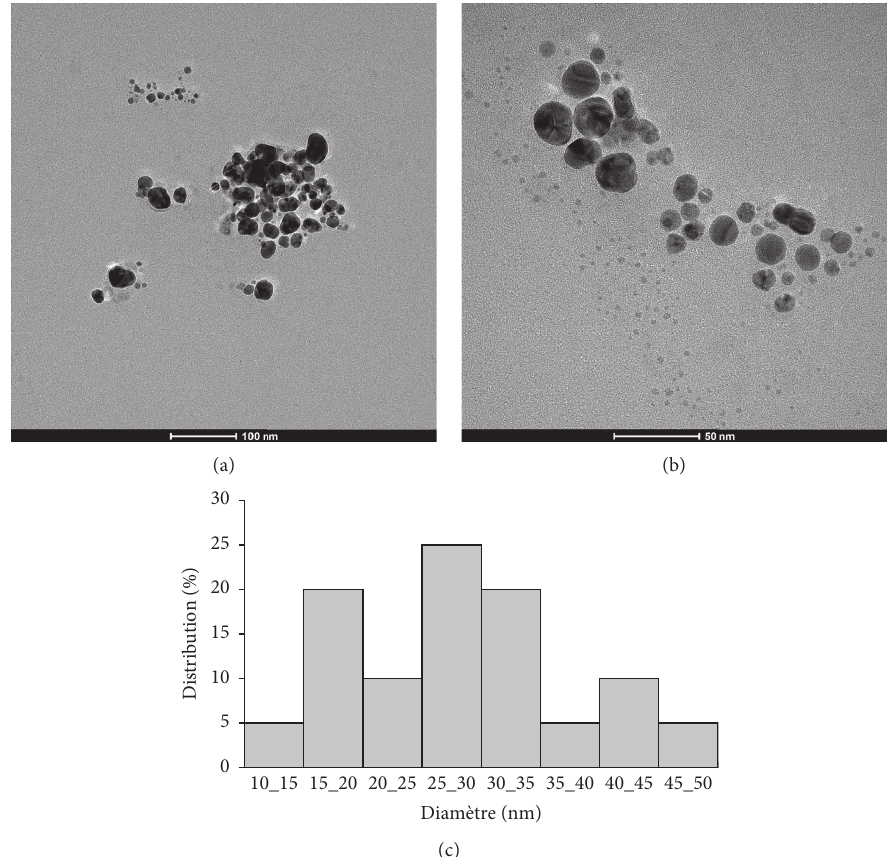
Figure 2: TEM analyses of biosynthesized AgNPs (a, b) using dried peel of orange ( Citrus sinensis ) extract and their size distribution (c).